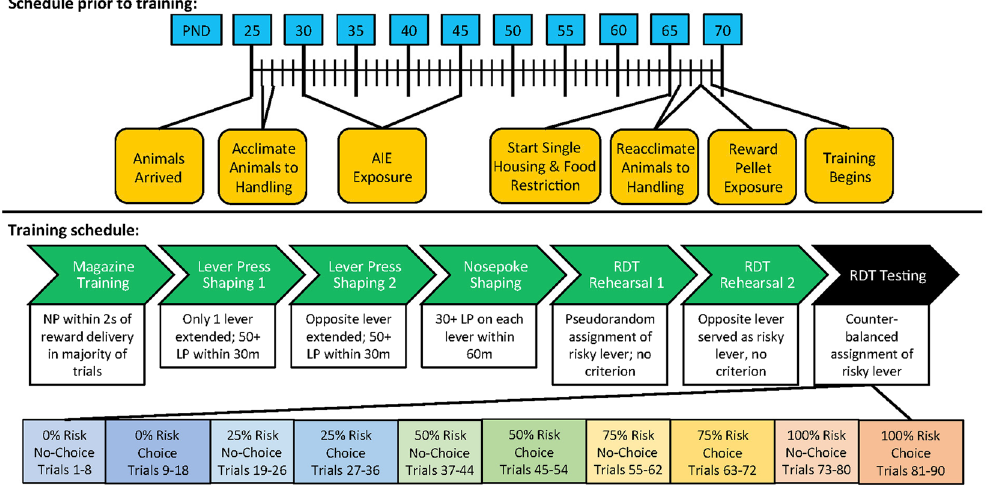
Figure 1. Treatment and training